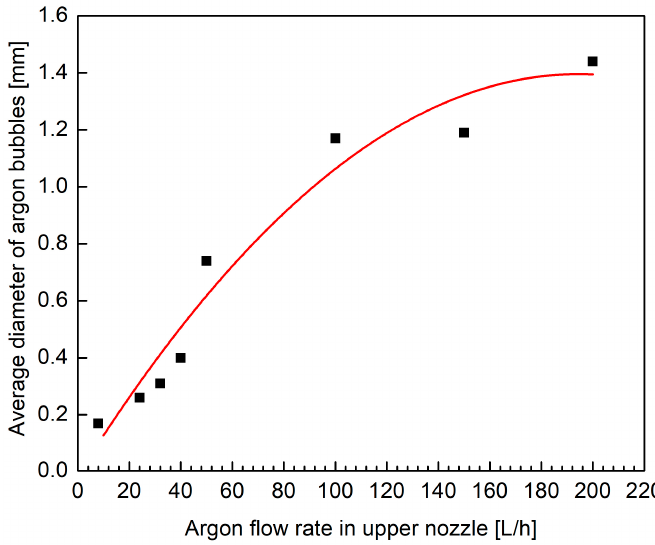
Figure 6. Average diameter of argon bubbles on the inner surface of the nozzle for different argon flow rates.